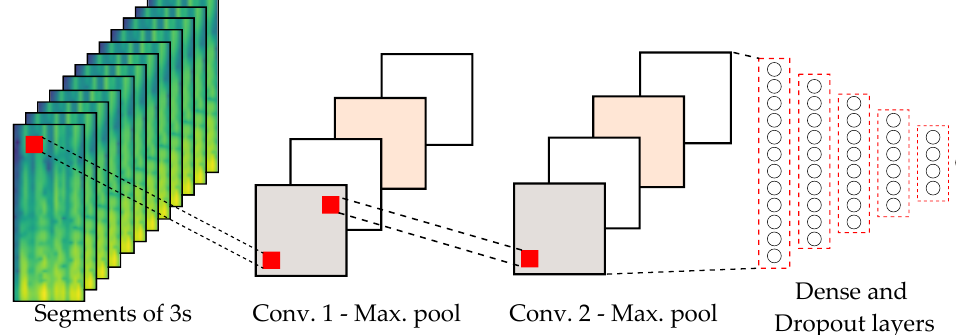
Figure 5. Architecture of the CNN implemented in this study.